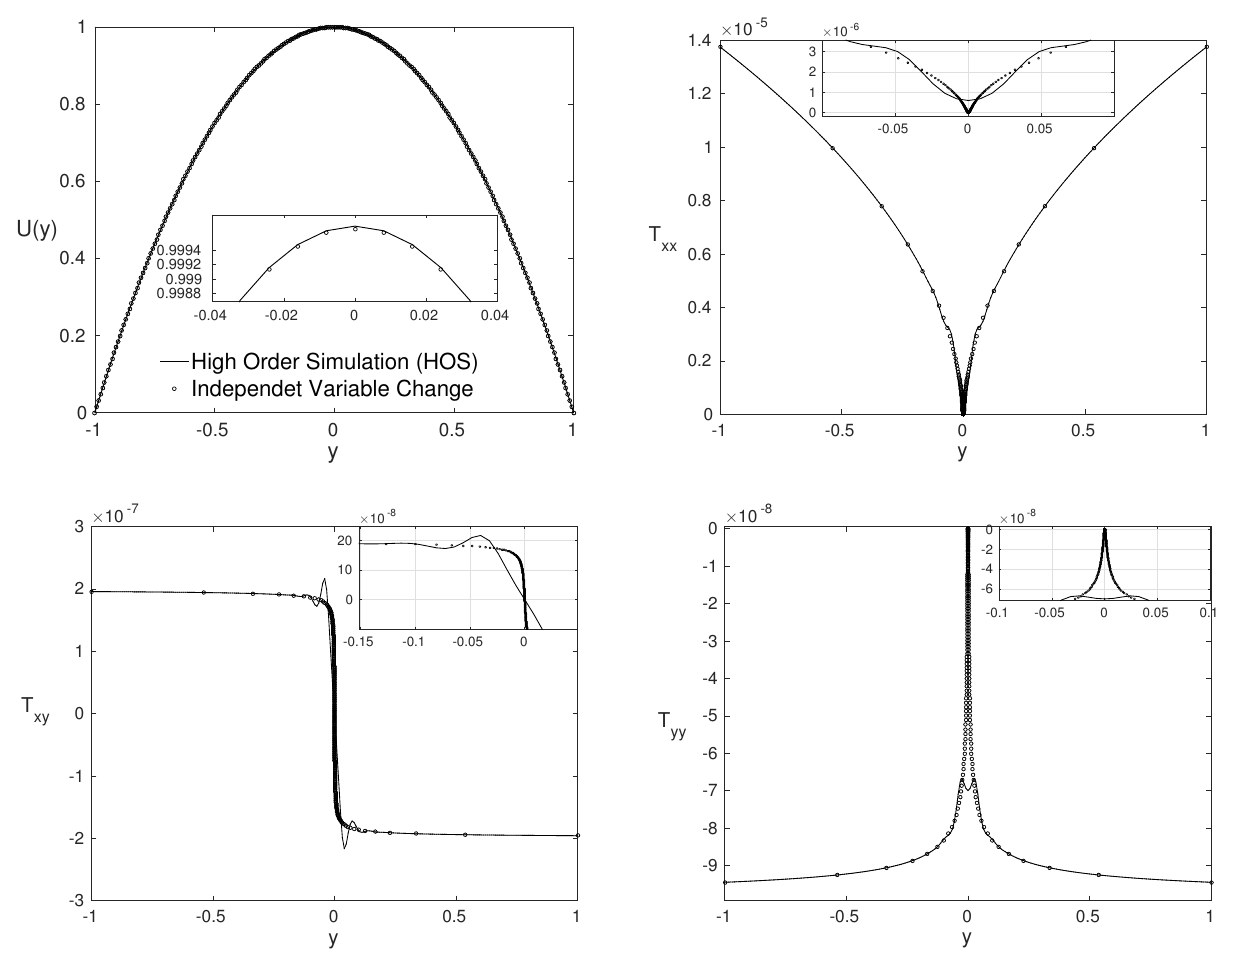
Figure 12. Same as in Figure 1 for dimensionless numbers: Re = 5000, β = 0.75, α G = 0.2 and Wi = 500. One may observe that the results obtained by the different formulations are in agree- ment. An interesting behavior presented by the HOS formulation can be observed. The results obtained by this formulation, for high Weissenberg numbers, show oscillations